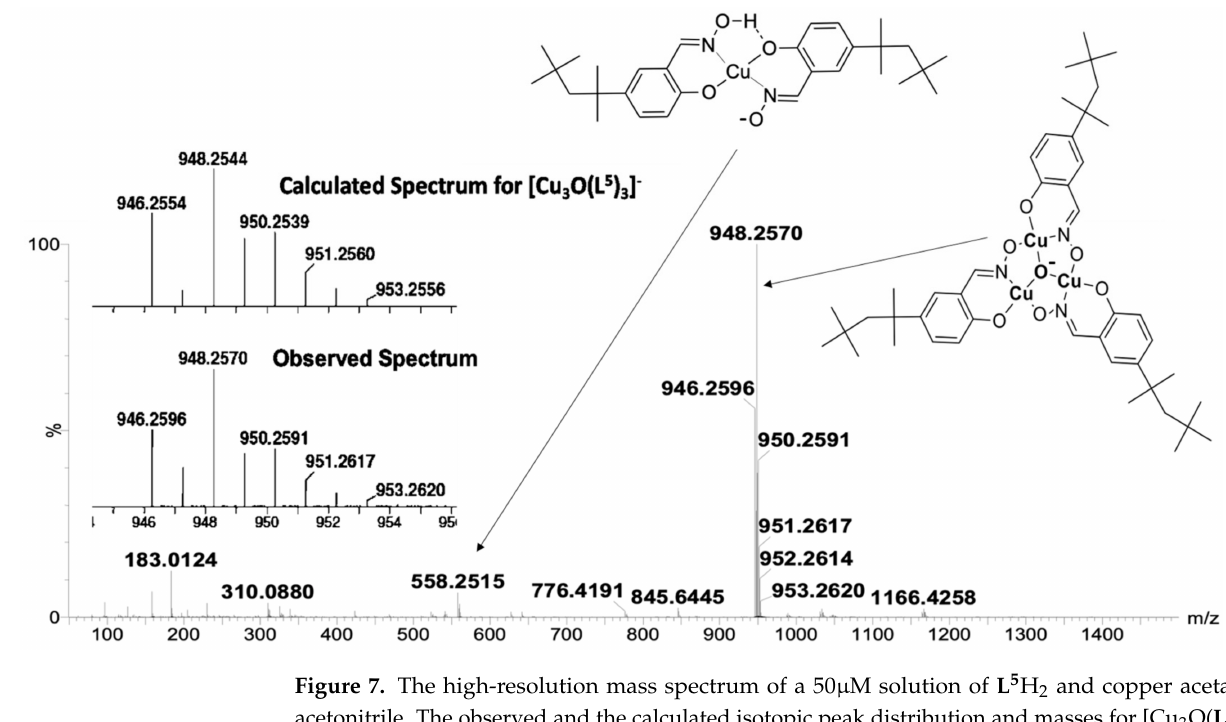
Figure 7. The high-resolution mass spectrum of a 50 µ M solution of L 5 H 2 and copper acetate in acetonitrile. The observed and the calculated isotopic peak distribution and masses for [Cu 3 O( L 5 ) 3 ] − are inset.